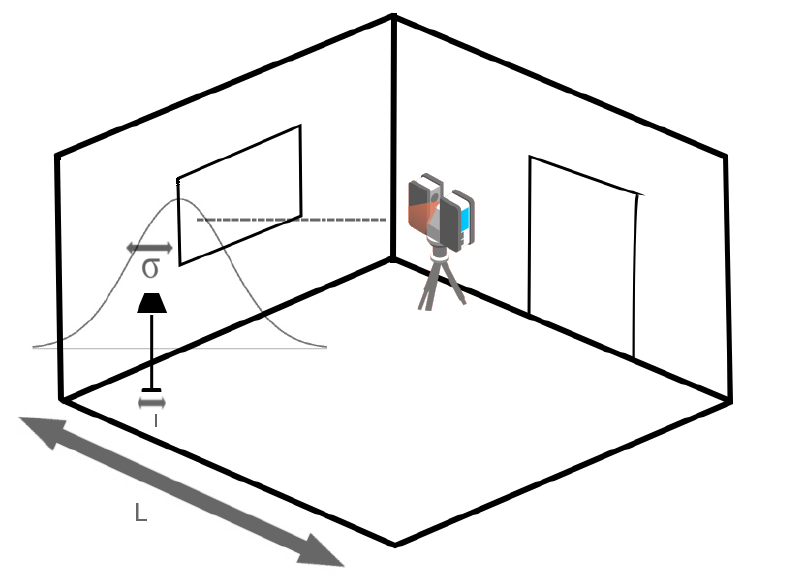
Figure 2. Depiction of the multi-scale problem. Indoor spaces and objects within have vastly different length scales, e.g., the width of foot of the lamp is a lot shorter than the width of the room, l (cid:28) L . Problems arise when the standard deviation of the scanning error is of the same length scale as some of these length scales, σ (cid:39) l . The deviation σ is exaggerated for illustration